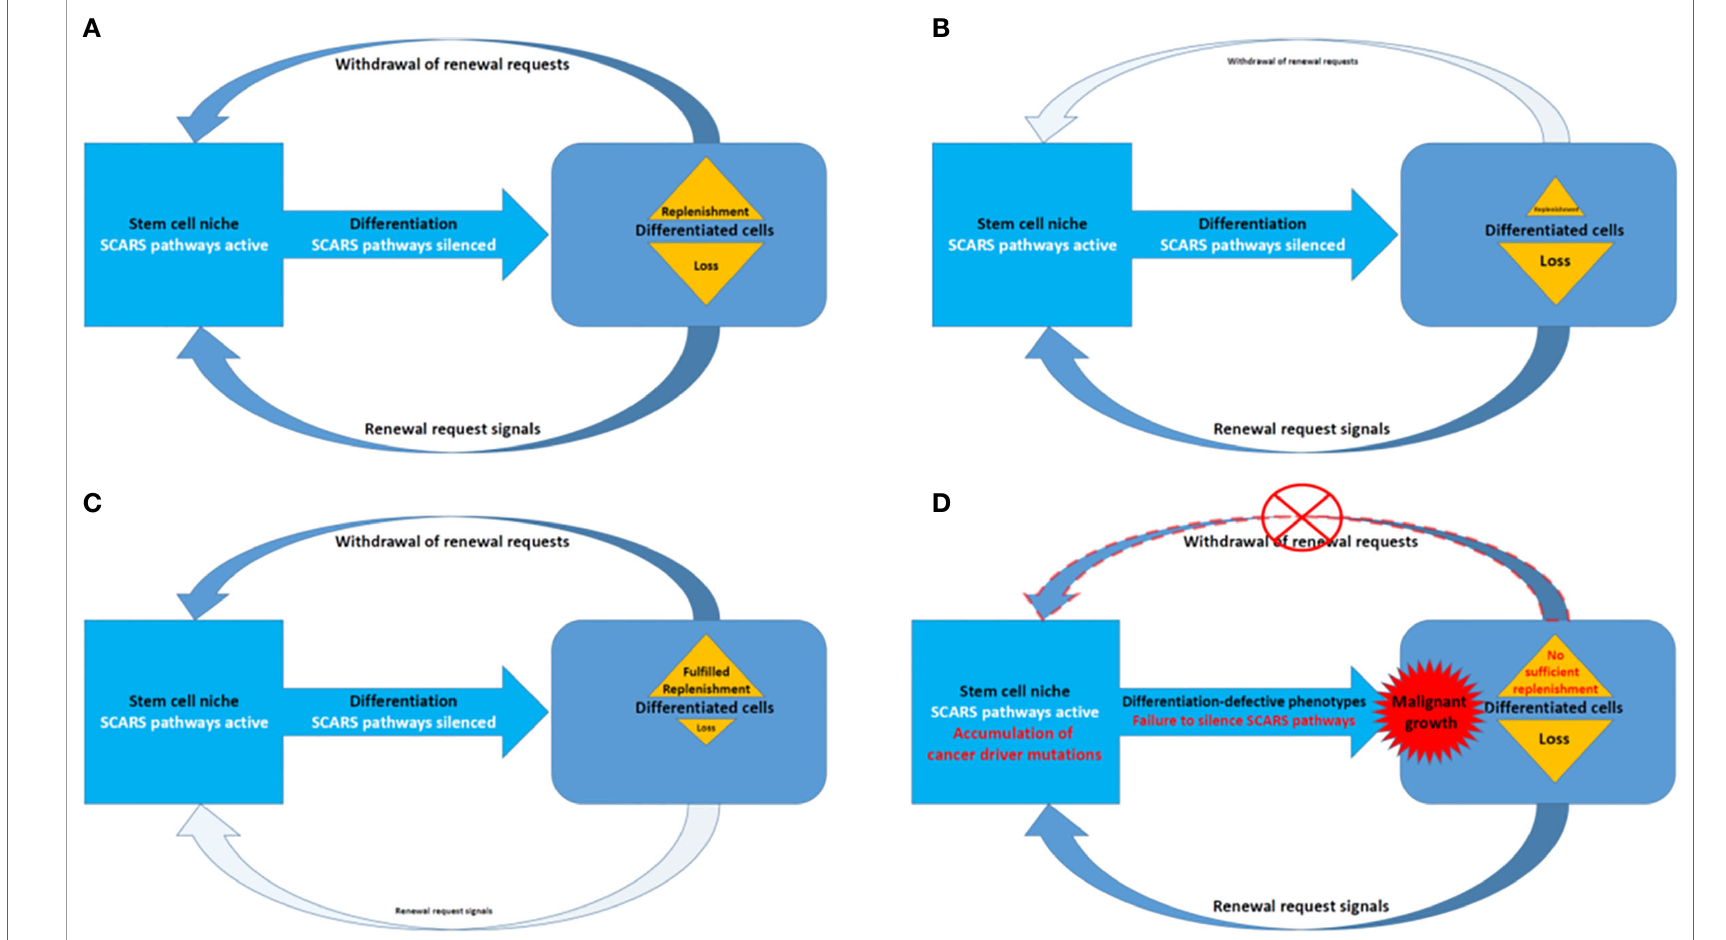
FIGURE 7 | A model of SCARS expression dependence of oscillation patterns of loss and replenishment cycles of dying differentiated cells. (A) A model of the loss/replenishment cycle in the balanced state. (B) A model of the cycle at the prevalent loss of differentiated cells state. (C) A model of the cycle at the completed replenishment of differentiated cells state. (D) A model of the cycle with failed replenishment of differentiated cells due to failure of the SCARS silencing during attempts toward